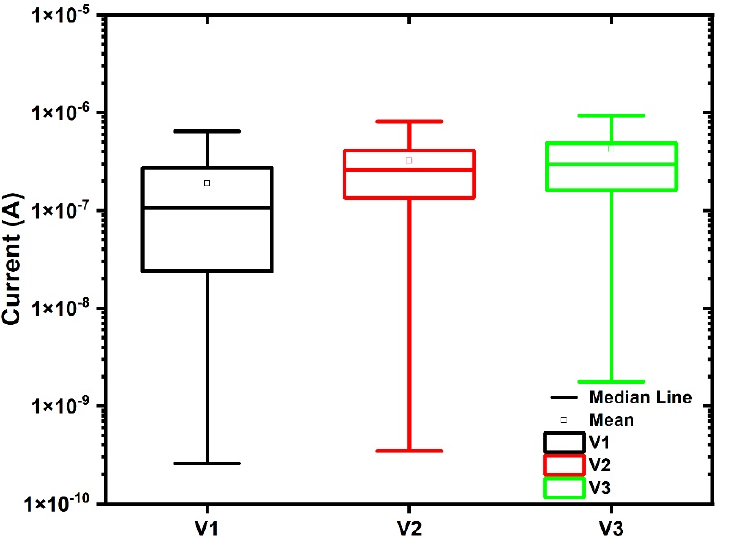
Figure 8. HRS currents extracted from DC set operations of V1, V2 and V3 memristive devices.